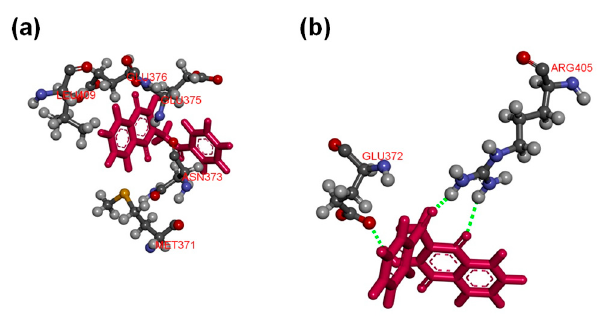
Figure 3. ( a ) Compound 12 does not form any hydrogen bonding interactions with the neighbouring amino acid residues of Hsp90 α MD (PDB ID: 3Q6M) at the binding pocket (10 Å around Glu-375); ( b ) compound 12 forms hydrogen bonds with residues Glu-372 and Arg-405 of Hsp90 β MD (PDB id: 3PRY) at the binding pocket (10 Å around Asp-367). Both of the displays were processed from the